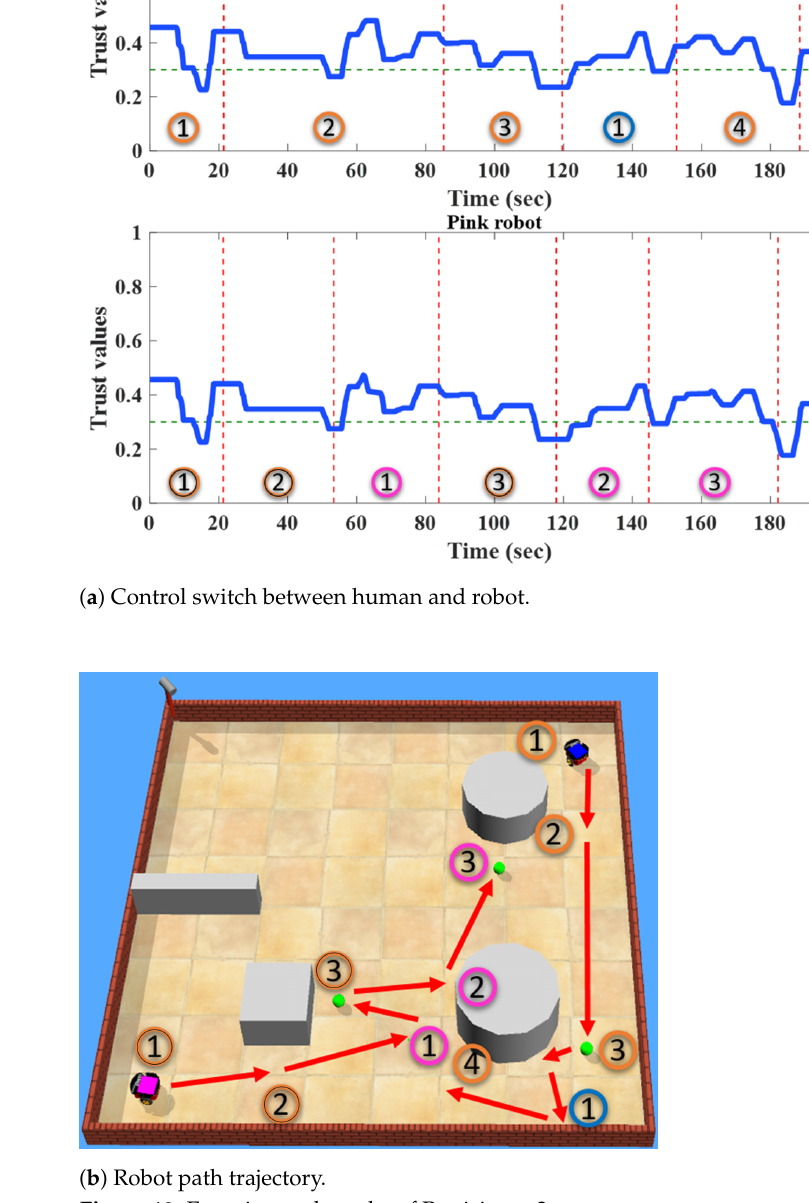
Figure 10. Experimental results of Participant